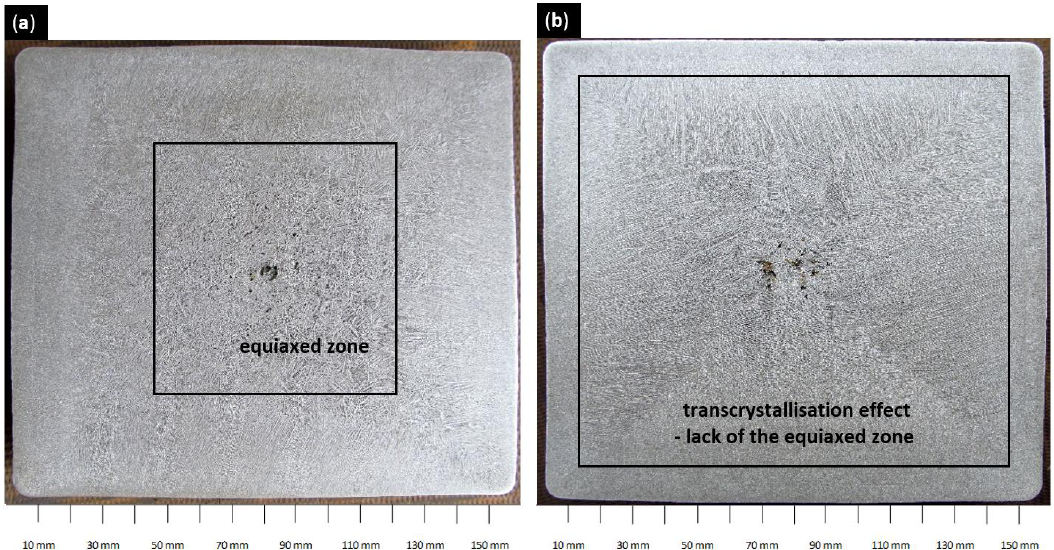
Figure 11. Cast strand structure ( a ) strand number 1, sample number 10, and casting speed 1.8 m/min; ( b ) strand number 1, sample number 10, and casting speed 2.5 m/min.